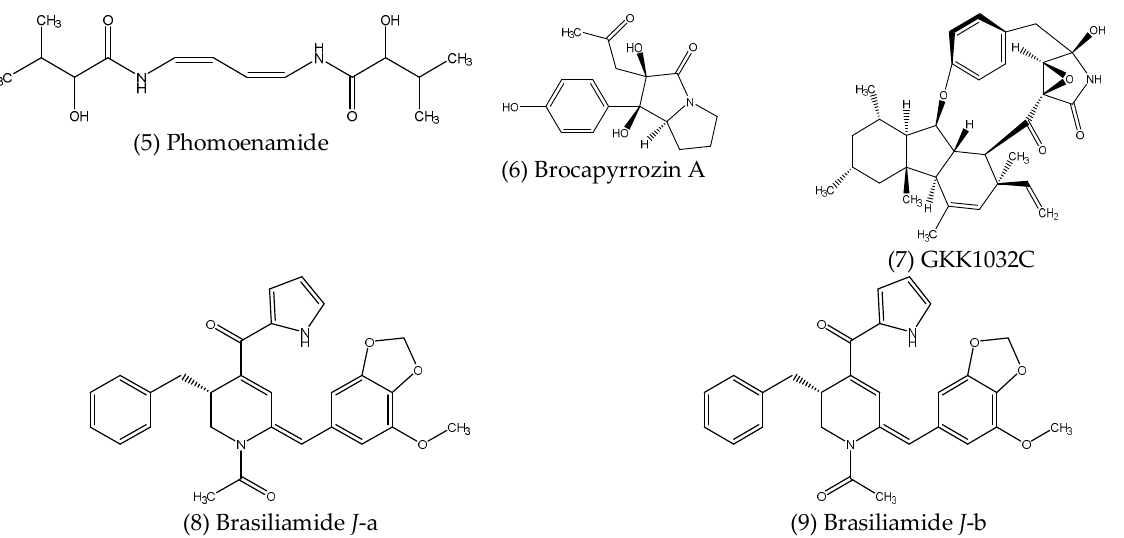
Figure 2. Structures of antimicrobial alkaloids and other nitrogenous compounds produced by endophytes.